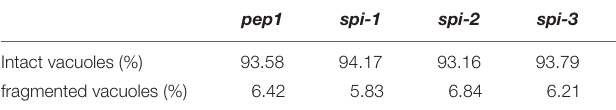
TABLE 3 | Vacuole integrity in pep1 and Aaspi